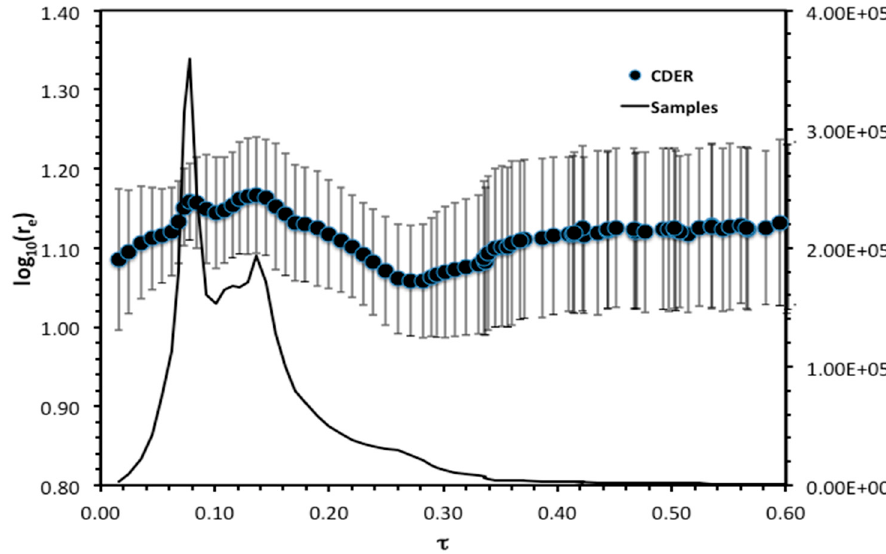
Figure 4. The correlation plot between AOT ( τ ) and the logarithm of CDER ( r e ) for the long-term averaged global monthly mean data over ocean (dots) along with the number of data samples (line), which is binned according to AOT with a 0.01 increment denoted on the right-hand axis. The error bars indicate one standard deviation.